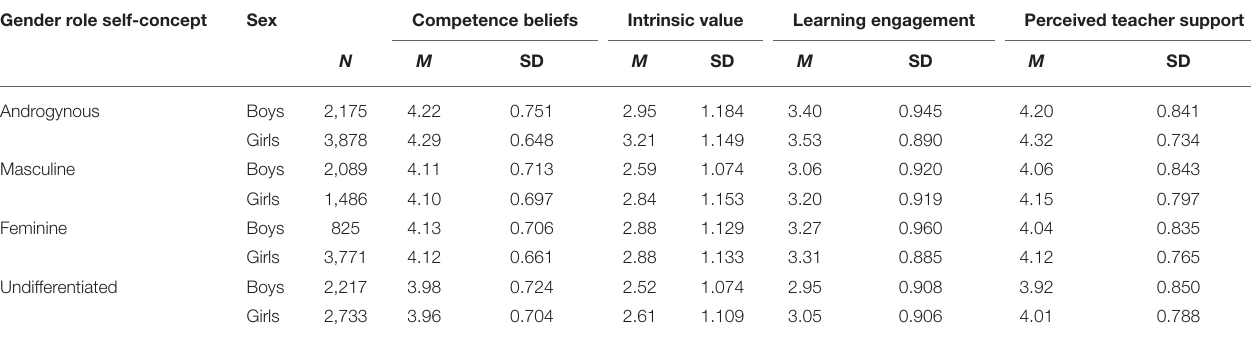
TABLE 1 | Means and standard deviations of digital learning components by gender role self-concept and sex. Gender role